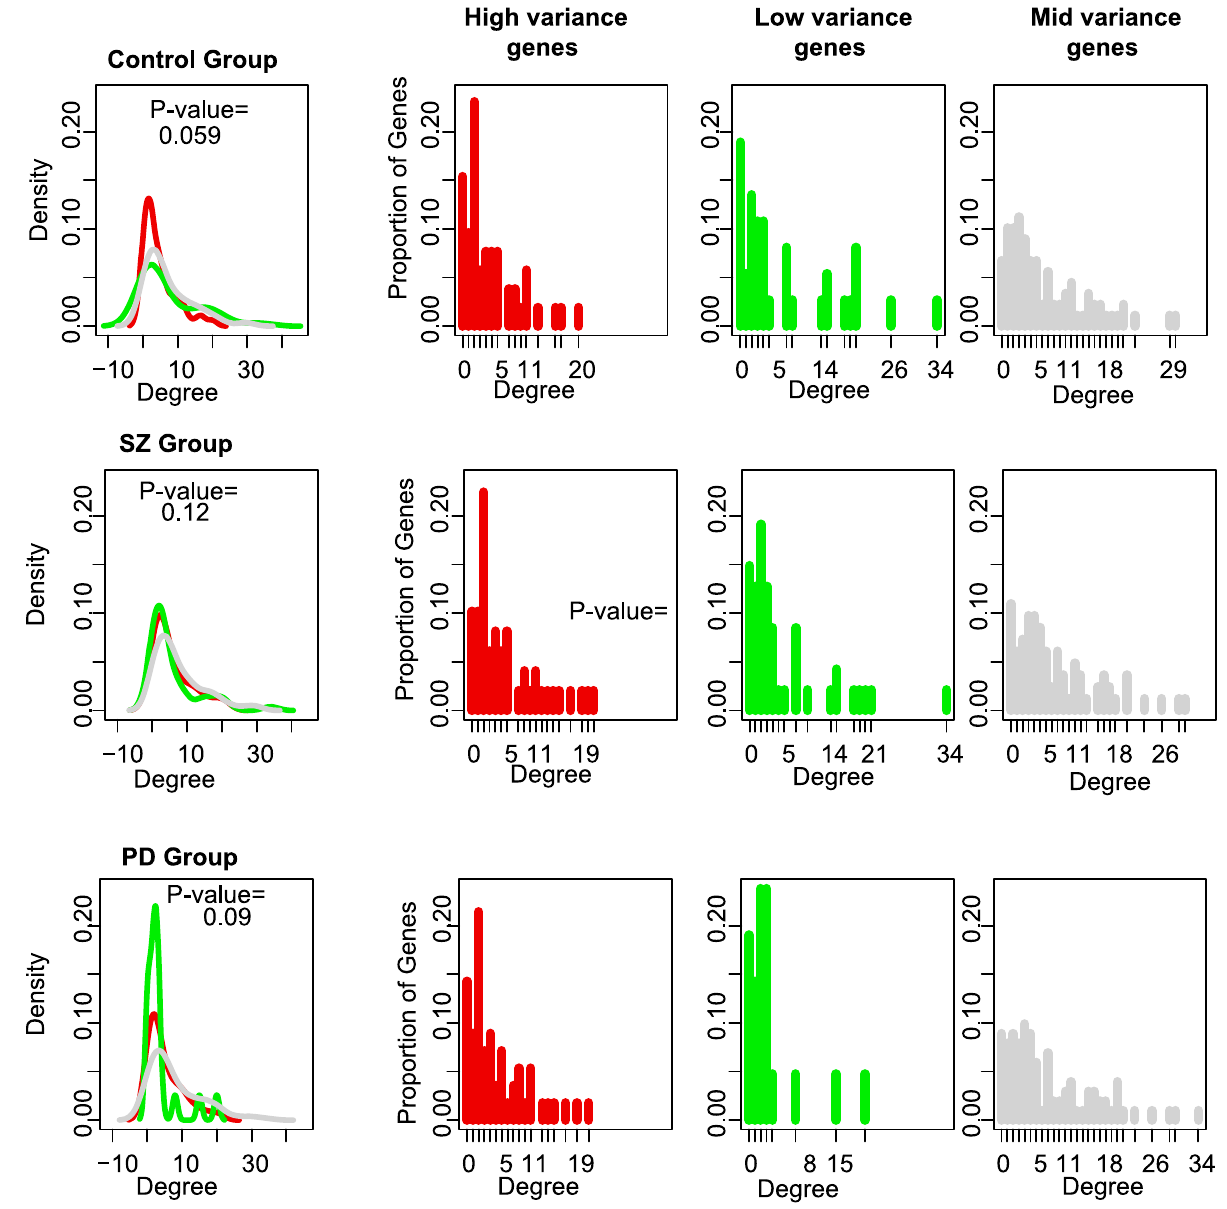
Figure 5. MAPK interaction networks and degree distribution density curves for the highly-constrained (red) and lowly-constrained (green) genes. p-values assess the significance of how different the two degree distributions are. The ‘‘Mid Variability’’ genes, falling between the 25th and 75th percentile of CV values, are shown in gray for comparison.